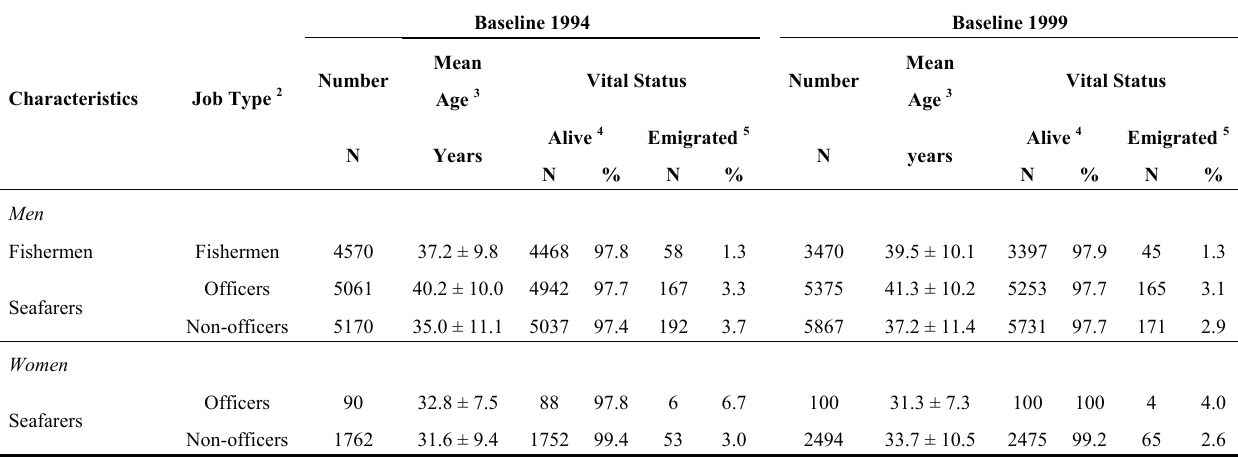
Table 1. Danish fishermen and seafarers at baseline by gender and occupation 1